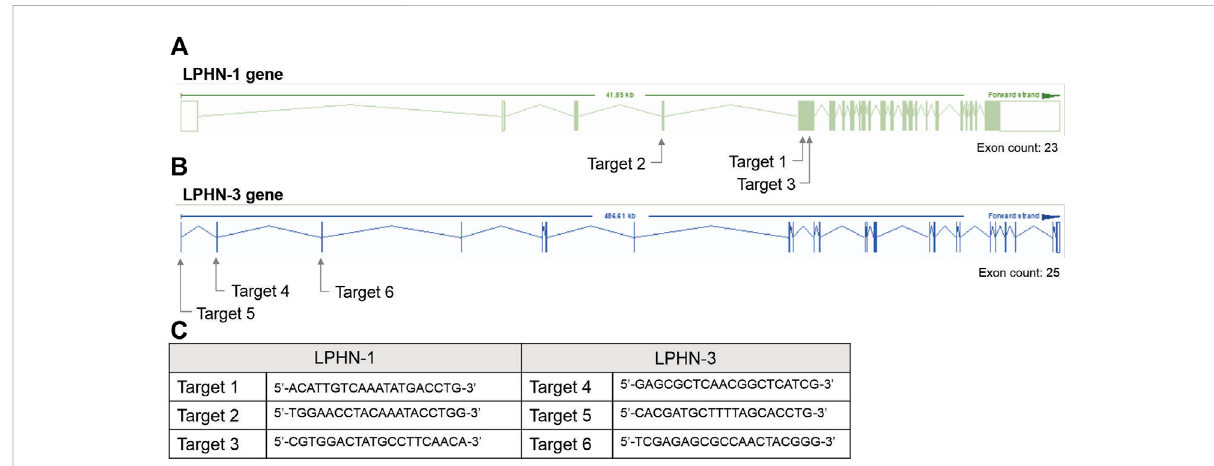
FIGURE 2 CRISPR-based targets for the mouse LPHN-1 and -3 genomic sequences. (A) . Schematics of LPHN-1 and -3 genomic organization. The oligonucleotidestargetingtheseregionsareindicatedasarrows. (B) .Sequenceoftheoligonucleotides usedintheCRISPRknockdownsasindicated in “ A ” above. (C) Sequence of oligonucleotides indicated in A and B